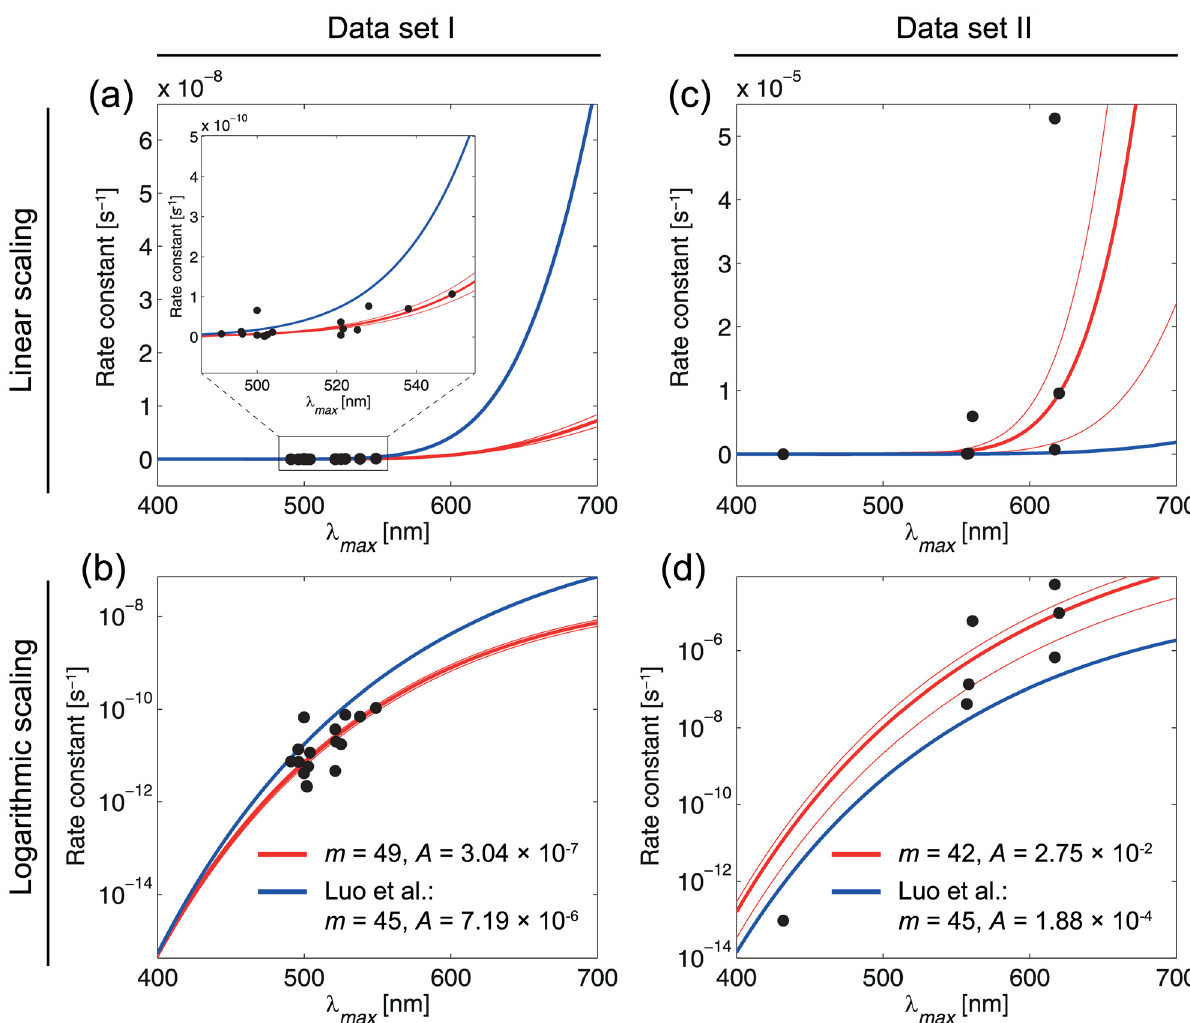
Fig 1. Fitted functions (rate constant vs λ max ) according to Eq (7) with optimal m -values (red), and m = 45 (blue) as predicted by Luo et al [2]. Shown are the results with a linear (a, c) and logarithmic scaling (b, d). It is seen that m = 45 is not an optimal value relative to m = 49 for rods and m = 42 for